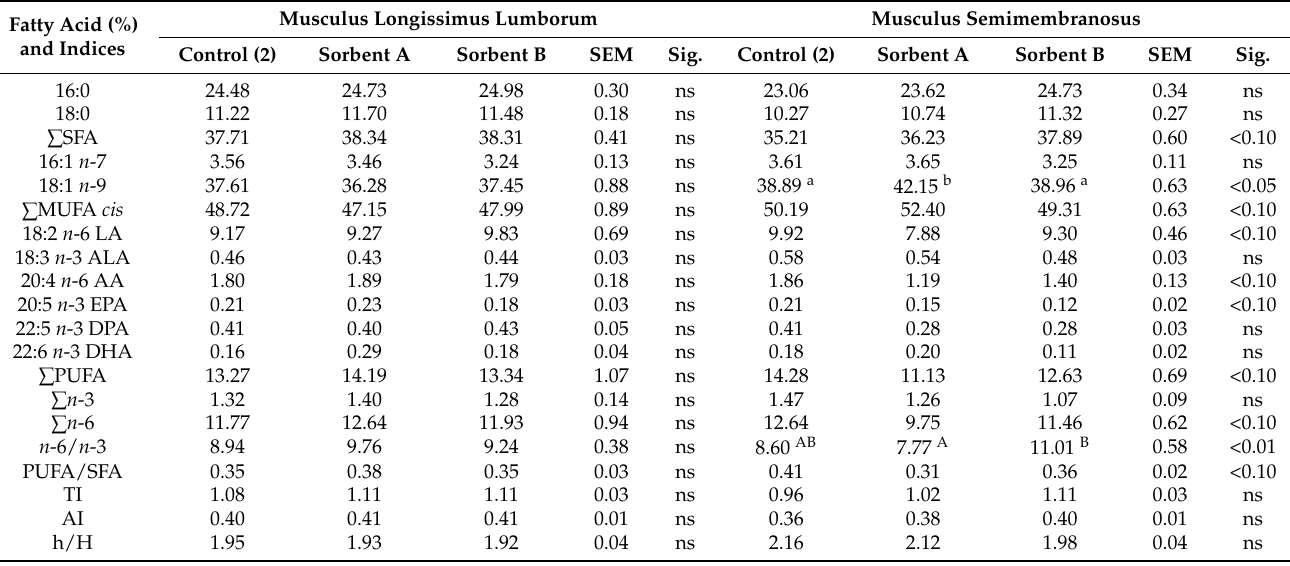
Table 3. Composition of fatty acid (% of total fatty acids) of Musculus longissimus lumborum and Musculus semimembranosus.